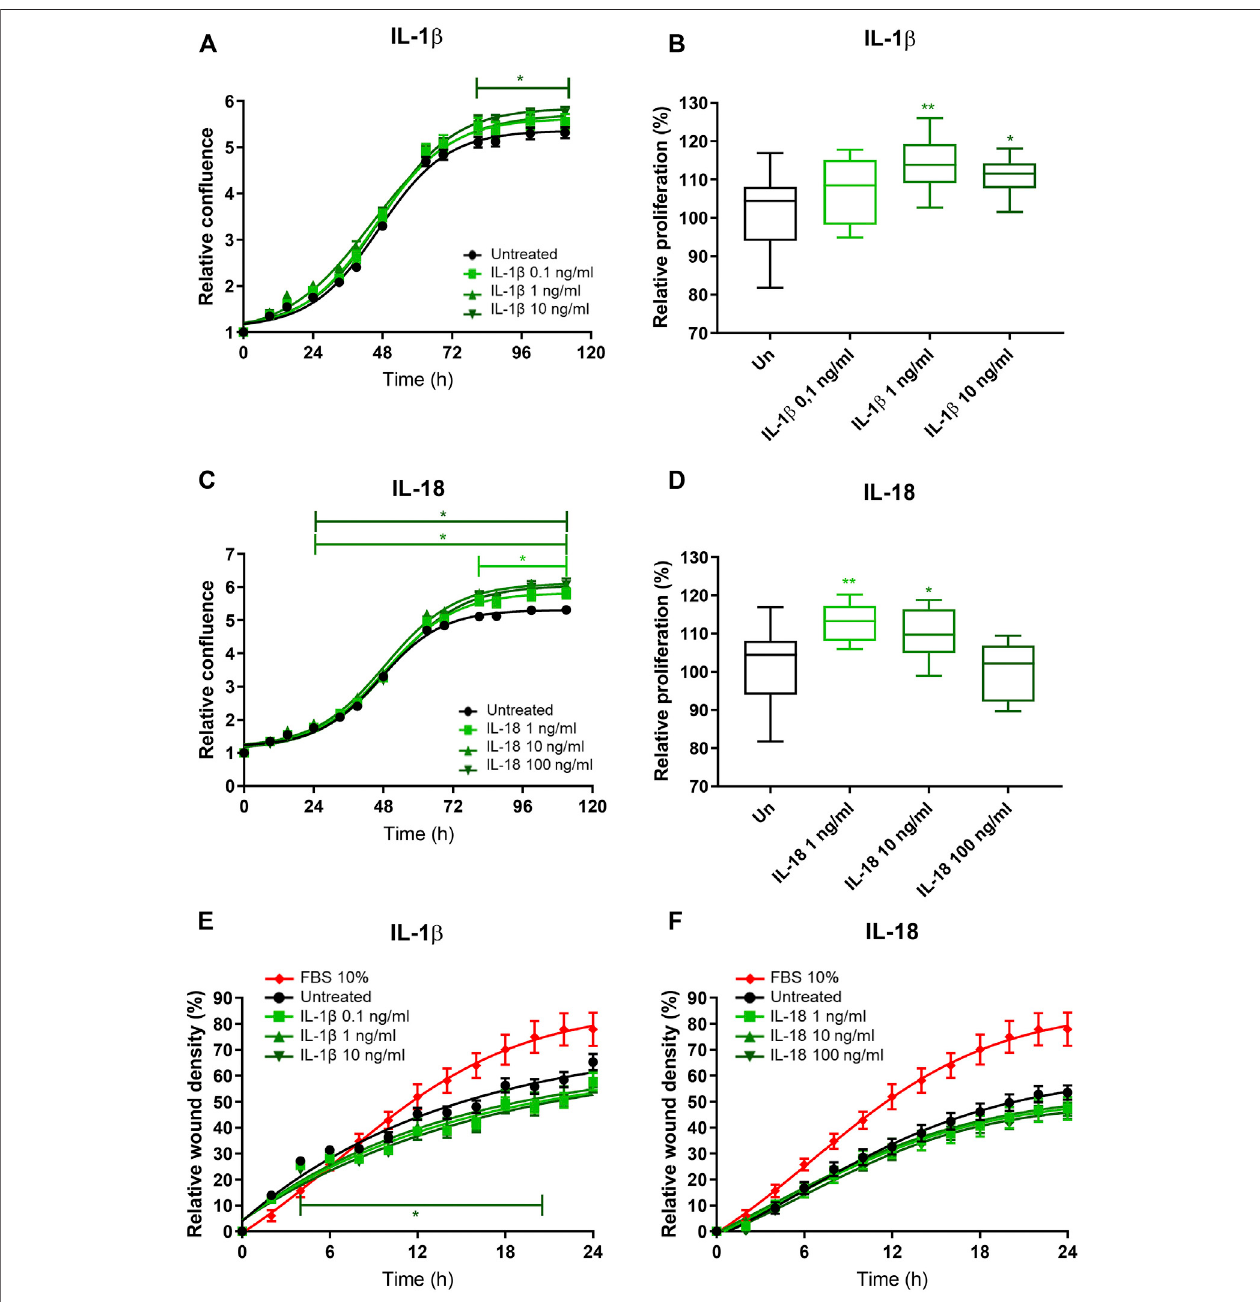
FIGURE2| IL-1 β andIL-18effectsoncardiac fi broblastproliferationandmigration. (A – C) Relativecon fl uencenormalizedonT0and (B – D) relativeproliferationwith respect to the untreated (setted to 100%) and (E,F) relative wound healing density normalized on T0 of human immortalized fi broblasts exposed to different concentrations of (A,B – E) IL-1 β and (C,D – F) IL-18 ( n = 8). Data are expressed by mean ± SEM. * p < 0.05; ** p < 0.01 vs. untreated.